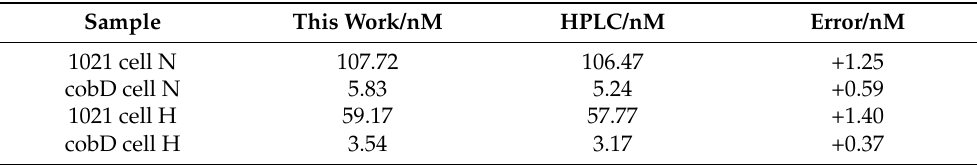
Table 3. The comparison of this work and HPLC method for VB12